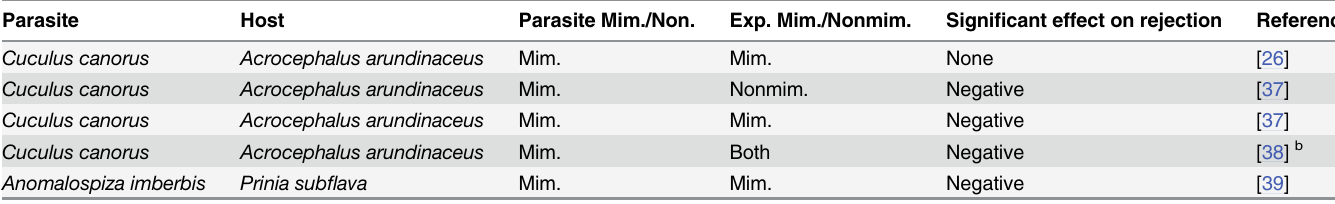
Table 2. Summary of published studies on egg rejection responses (relative to controls) to experimental brood parasitism, where the methodology included manipulations to increase intraclutch egg appearance variation. a